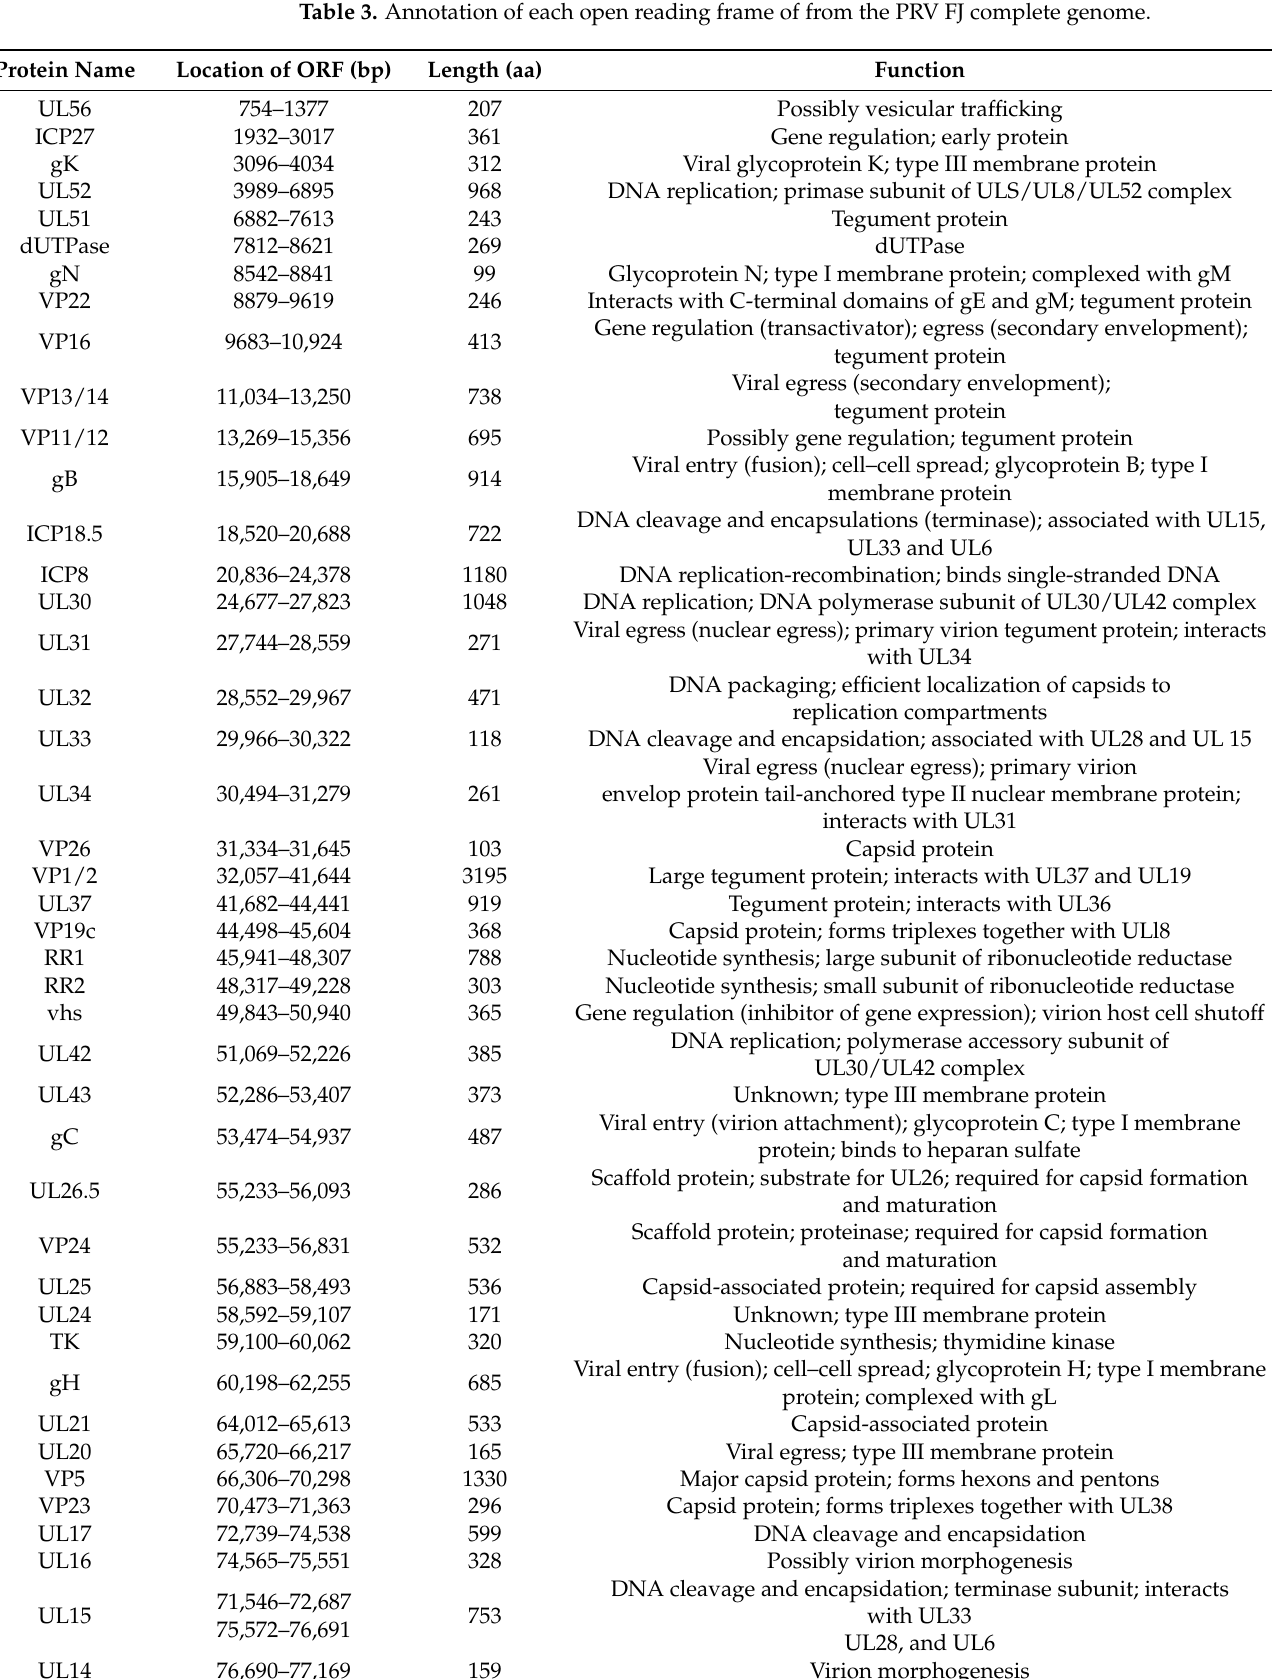
Table 3. Annotation of each open reading frame of from the PRV FJ complete